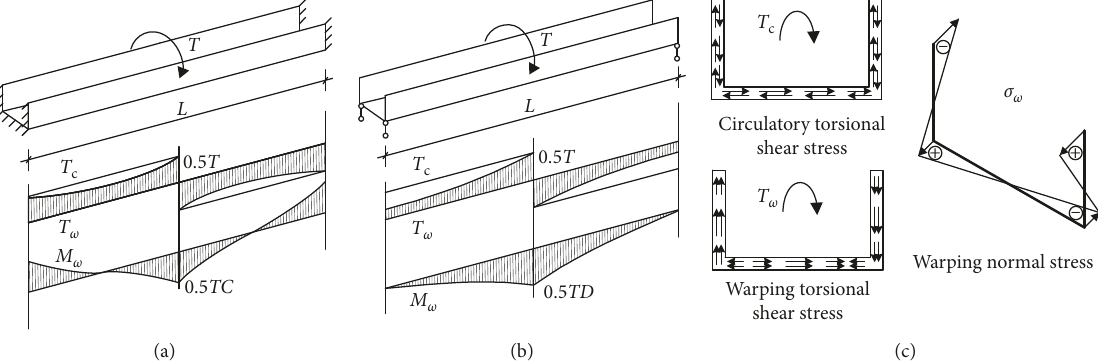
Figure 1: Distributions of internal forces and the corresponding stresses: (a) internal forces in a fixed-fixed supported case, (b) internal forces in a simply supported case, and (c) stress distributions. Note: C cosh 0 . 5 L / k . ( )